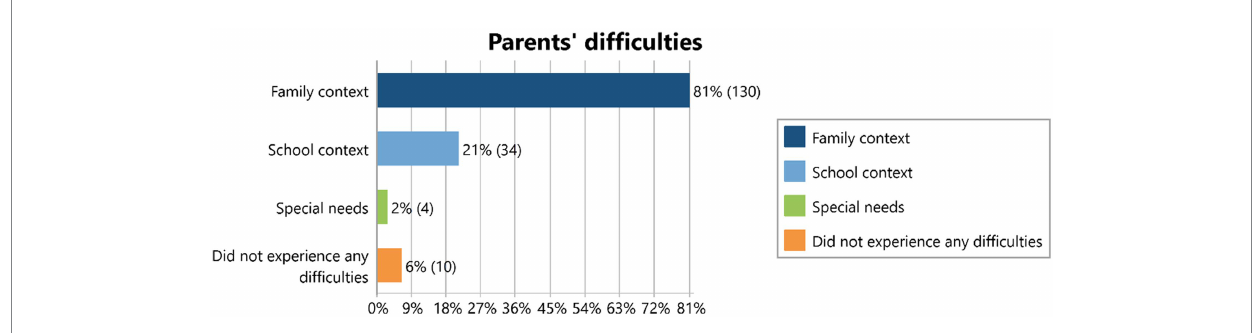
FIGURE 1 Frequency of documents referring to each subcategory within Parents’